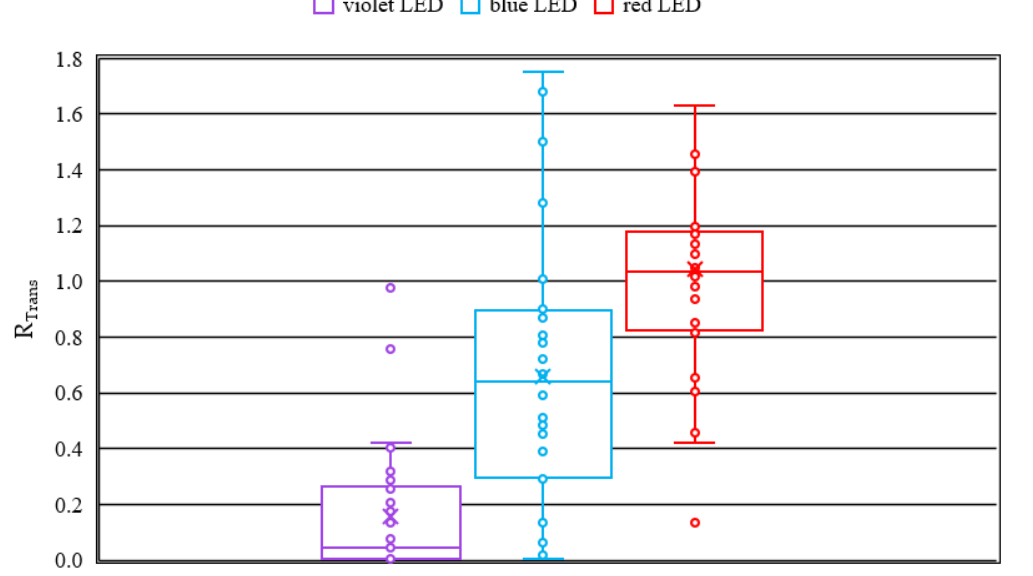
Figure 2. Boxplot overview of the transmission change R Trans in the visible range from 400 to 750 nm—calculated according to Formula (3).